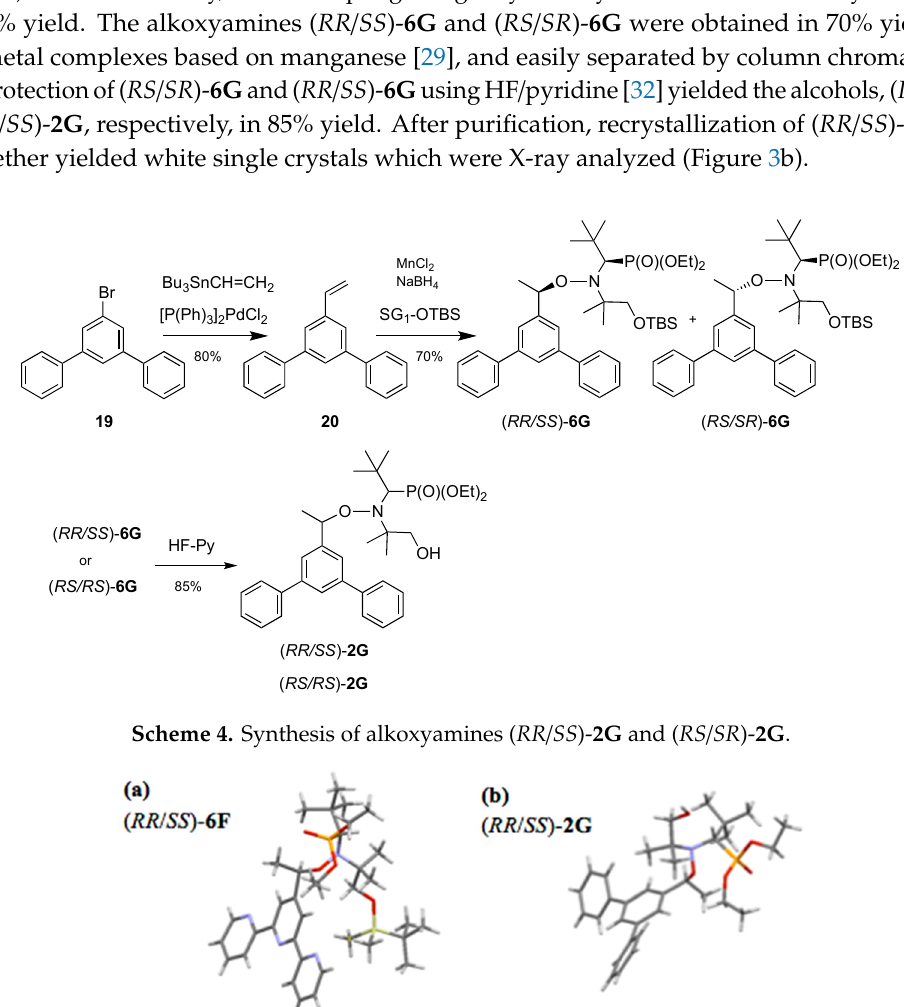
Figure 3. Ortep drawing from X-ray analysis of ( a ) ( RR / SS )- 6F (Figure 3a) and ( b ) ( RR / SS )- 2G .